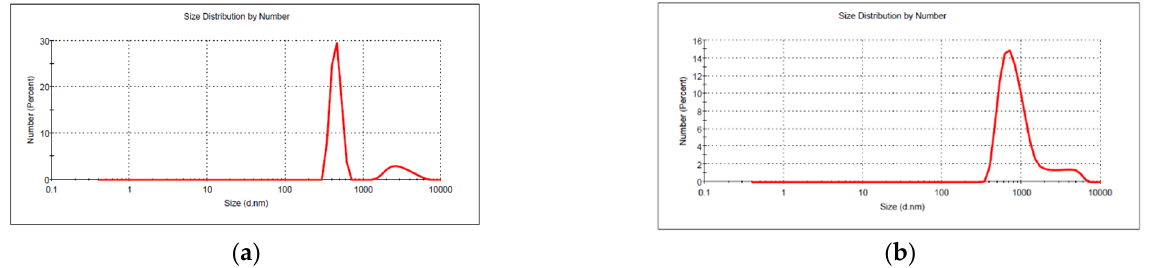
Figure 1. Size and size distribution of ZnO nanopowders obtained with ammonia (ZnO_Am2) ( a ) and Arginine/NaOH (ZnO_Arg1) ( b ), at 120 °C, 5 min microwave irradiation.